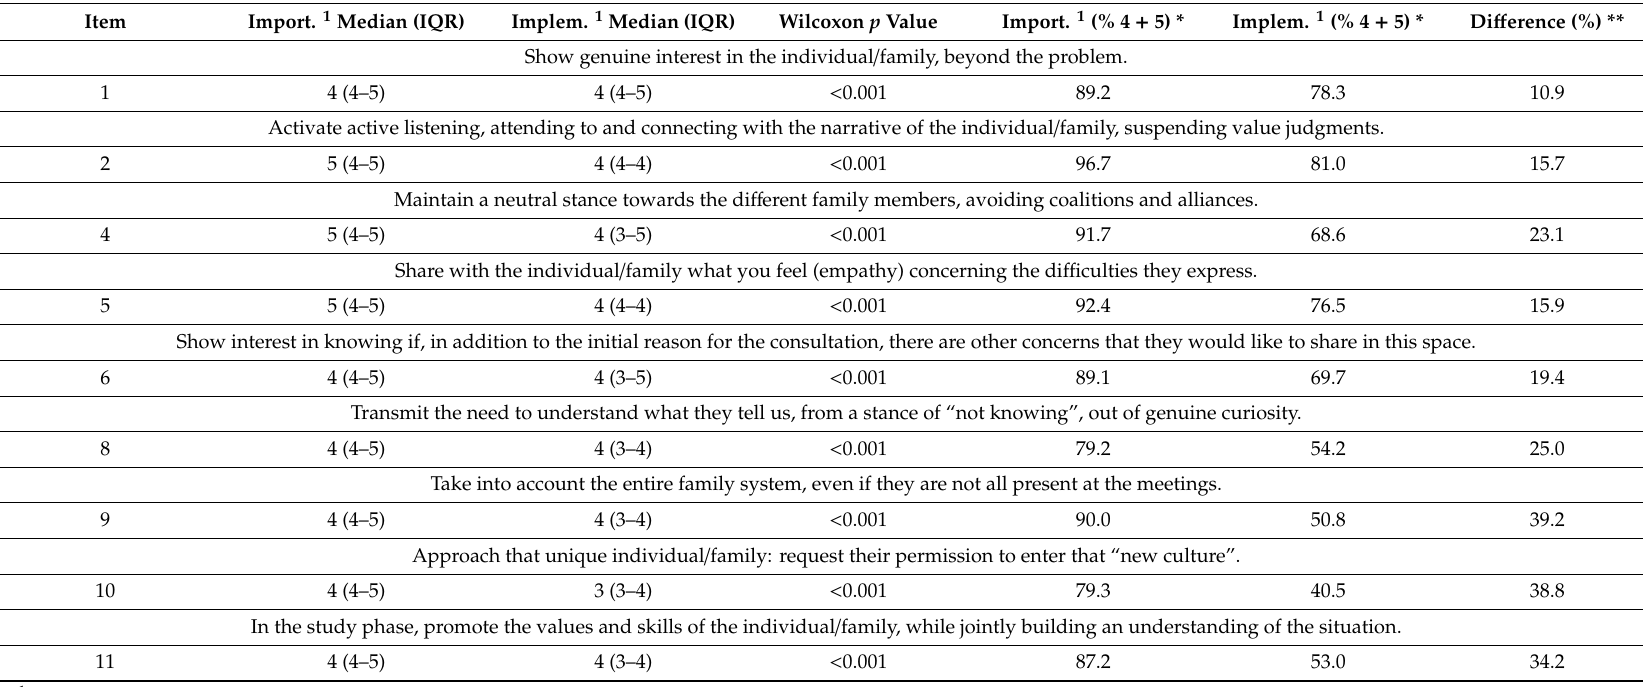
Table 6. Factor V: assessment of the stance of an appreciative